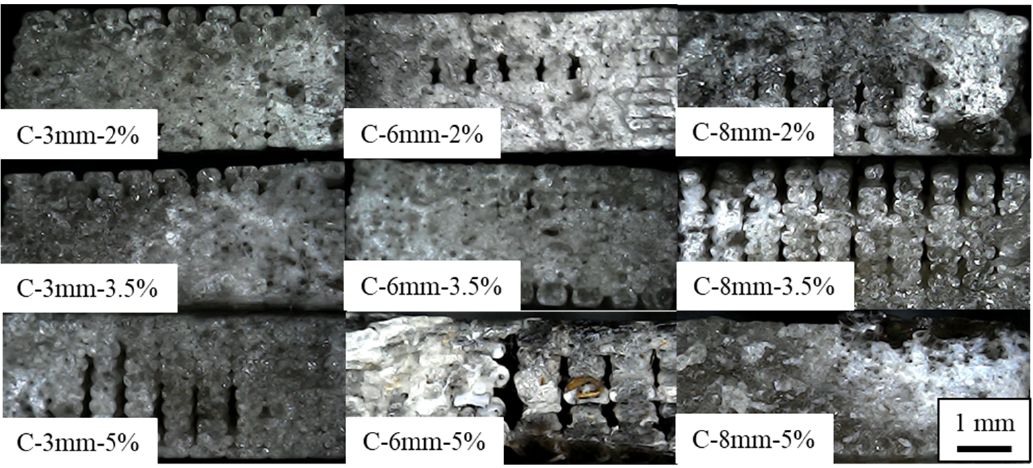
Figure 10. Representative failure modes of the 3D printed tensile specimens.